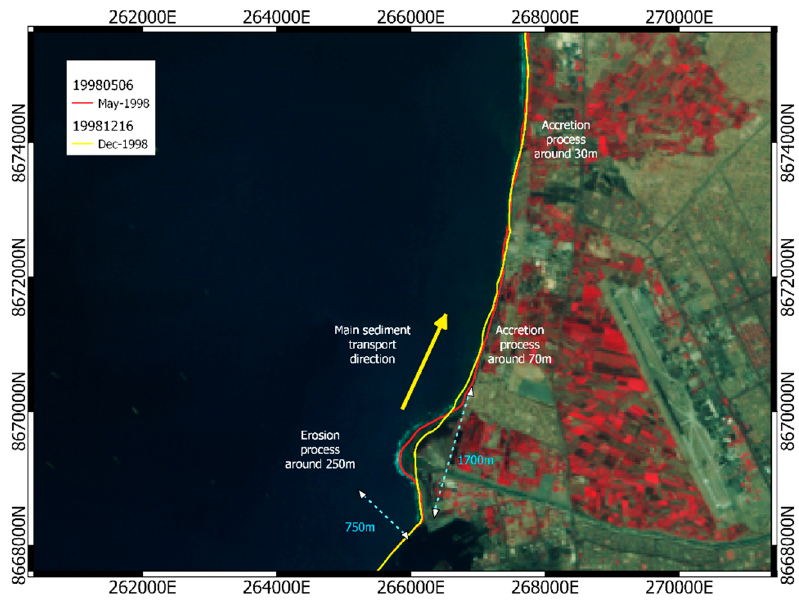
Figure 8. Shoreline evolution between May 1998 and December 1998.